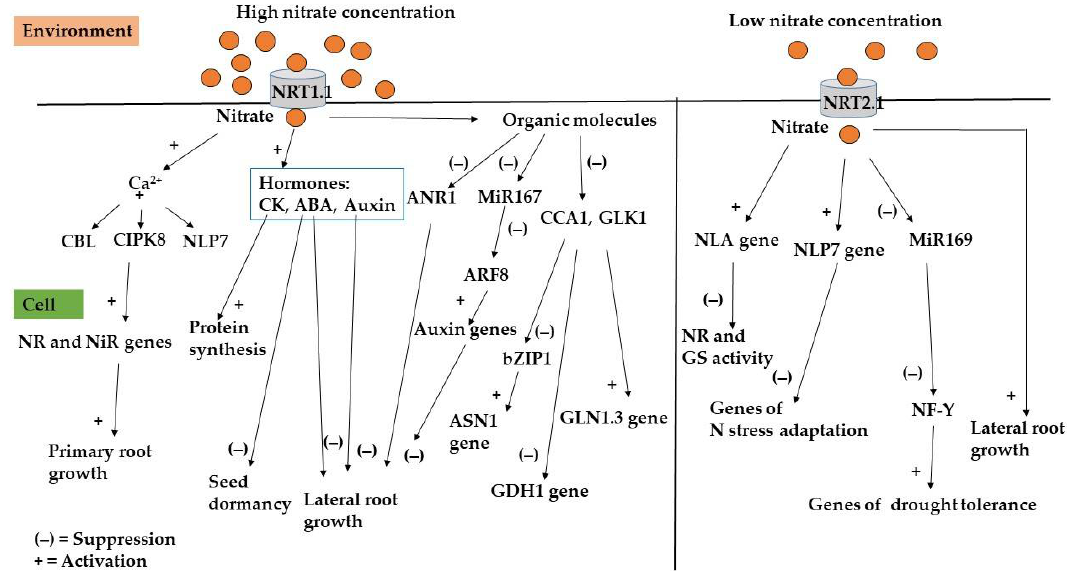
Figure 2. A schematic presentation of the interactions of the main genes involved in nitrogen transport in plants. Plant aquaporins (AQPs) are intrinsic proteins that form channels across plasma membranes and through which water and anions, such as nitrate, may pass [106]. The role of aquaporins in nitrogen absorption has been demonstrated by the different expressions of the AQP genes concerning the availability of nitrogen in the external environment. AtTIP1; 2 , AtTIP2; 1 , and AtTIP4; 1 genes encoding aquaporins in Arabidopsis , were found overexpressed under conditions of reduced nitrogen concentration outside the plant [24].